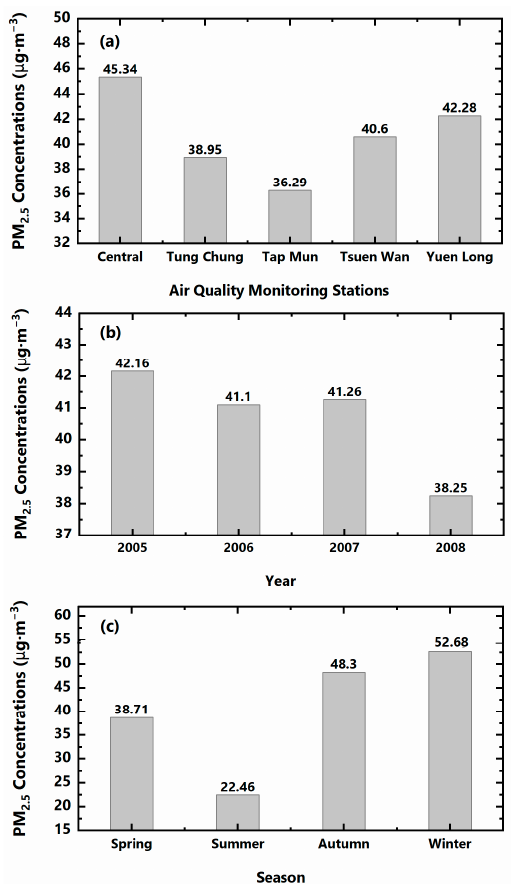
Figure 3. Four-year (2005–2008) mean PM 2.5 concentrations with respect to ( a ) air quality monitoring stations, ( b ) year, and ( c ) season.